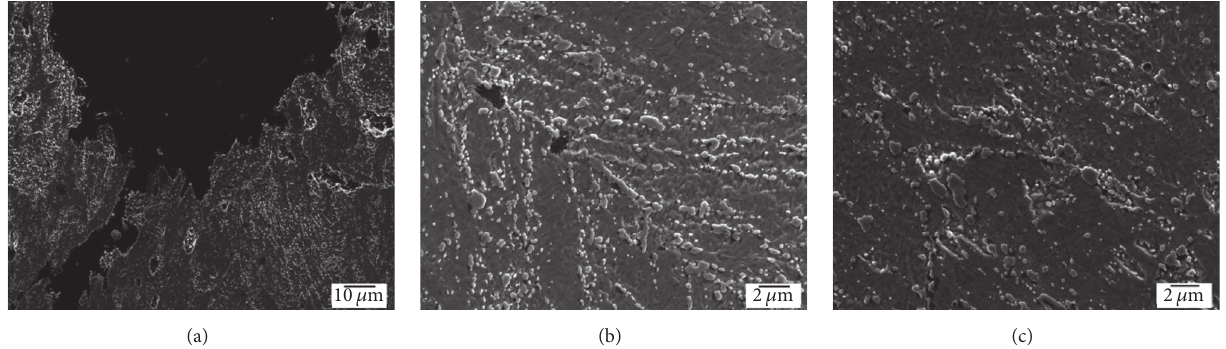
Figure 15: Fracture path (a) and creep cavities in WM (b) and nonruptured necked FZ (c) of CB2 weldment ruptured in WM by “type I failure” after the creep test at 625 ∘ C, 120 MPa.